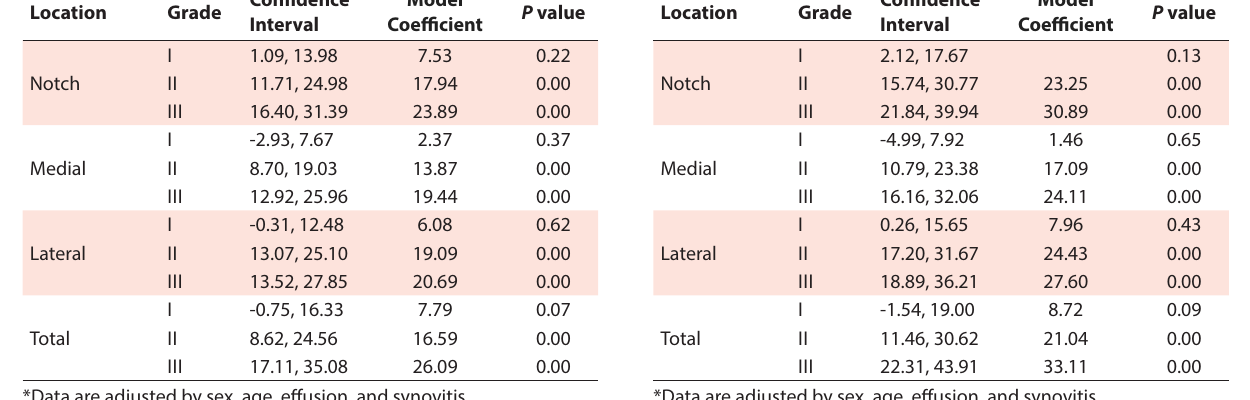
Table 2. Association between the trochlear cartilage grade and WOMAC physical activity index* Location